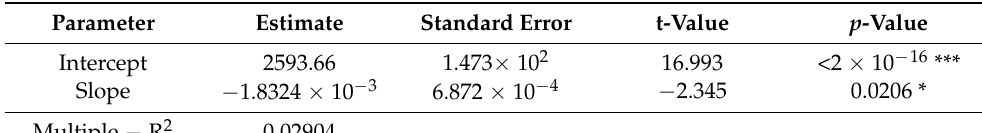
Figure 10. ( a ) The trained model and ( b ) the scatterplot of the measured vs. predicted canola seed yield for the testing set developed for the image acquired during late flowering (Model 3). Red line indicates the 1:1 line. Table 6. Parameter estimates of the trained simple linear regression model for the cumulative flower area.